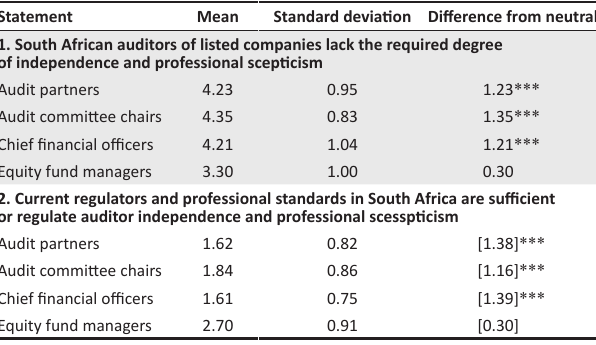
TABLE 1: Perceptions concerning the current status of independence and scepticism.